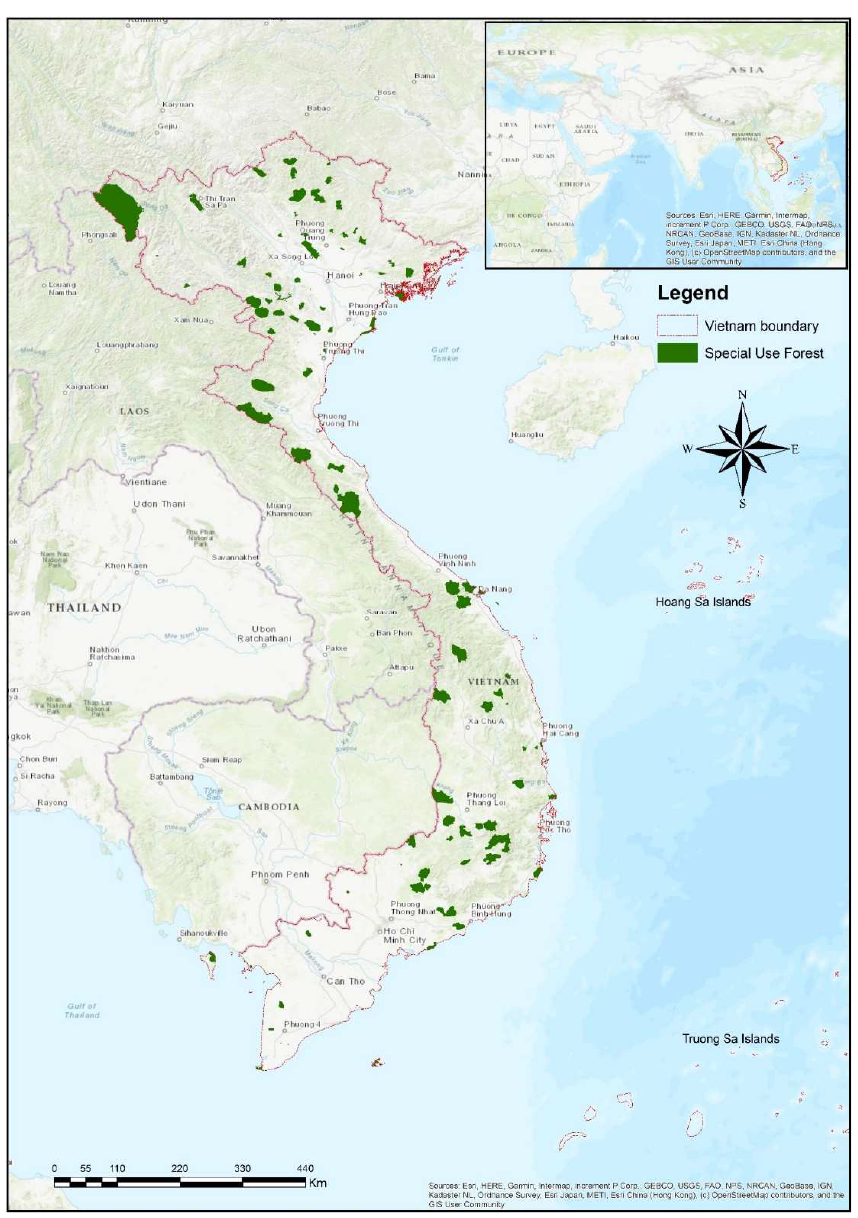
Figure 2. Map of Vietnam and the distribution of special-use forests for biodiversity conservation (Source: Modified from MARS and ESRI).